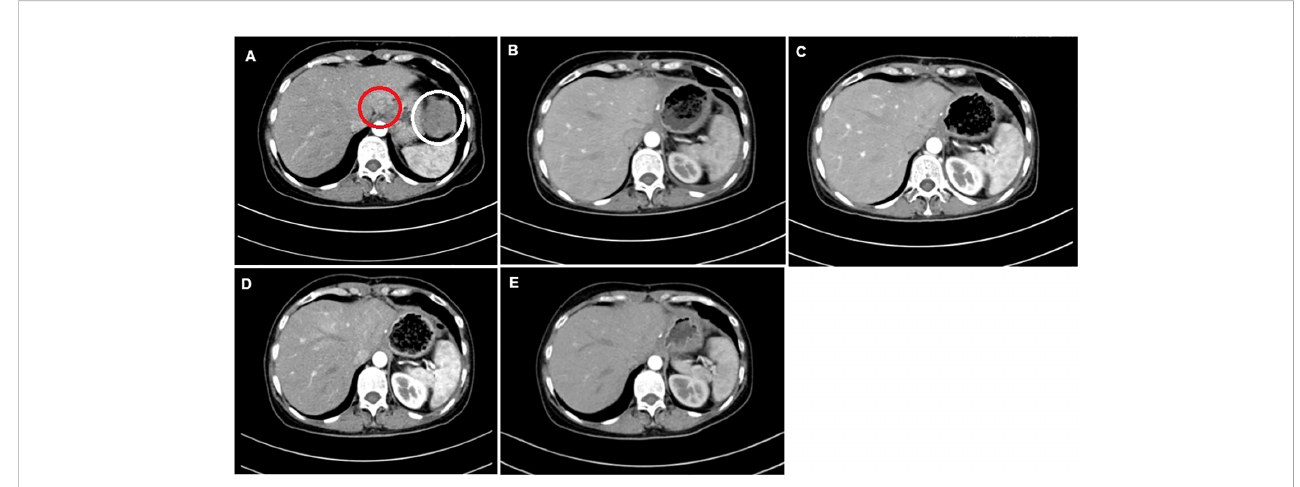
FIGURE 1 CT images of the 53-year-old female patient. (A) Tumor lesions of size 4.9 × 3.6 cm (red circle) and 7 × 6 cm (white circle). (B) Post-operative CT image before the fi rst cycle of the GS regimen. (C) CT image post-chemotherapy after the second cycle of the GS regimen. (D) CT evaluation post- chemotherapy after the fi fth cycle of the GS regimen. (E) CT evaluation post-chemotherapy after the sixth